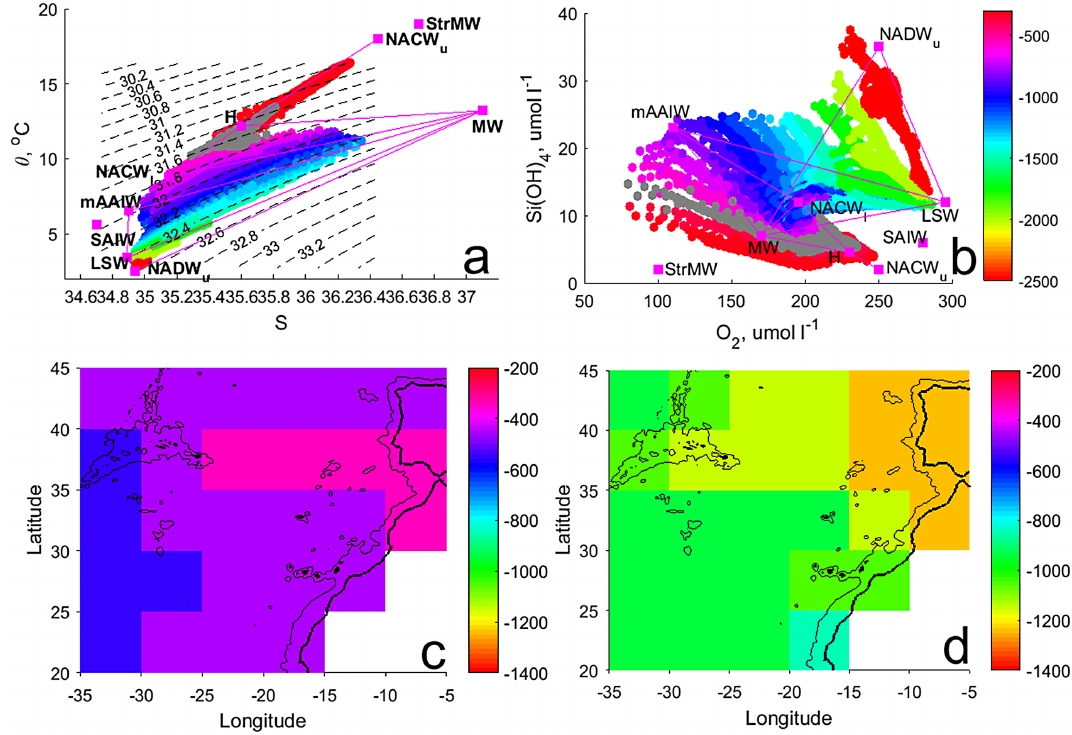
Figure 2. (a) θ -S diagram; (b) Si–O 2 diagram; (c) depth of the lower limit of layer 1 (m); (d) depth of the lower limit of layer 2 (m). Colour scale in panels (a) and (b) presents depth of the sample. The isopycnals in panel (a) are referenced to 1000m ( σ 1